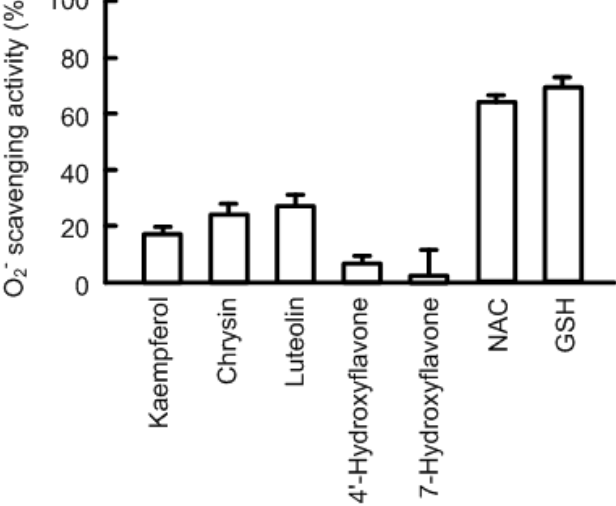
Figure 3. Antioxidant effects of flavonoids and antioxidants. O 2 − scavenging activity was examined using the hypoxanthine-xanthine oxidase system. Flavonoids (50 μ M), N -acetyl cysteine (NAC, 1 mM), and reduced glutathione (GSH, 0.1 mM) were mixed in the reaction buffer. n = 4.